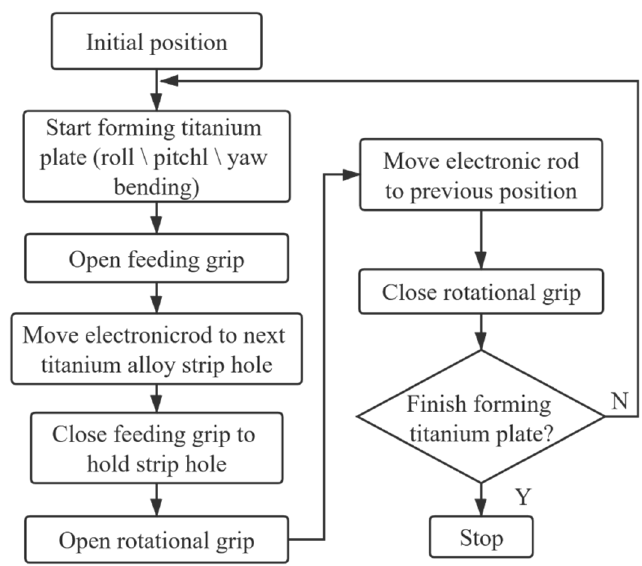
Figure 6. ( a ) Overall experimental device of the forming robot. ( b ) Zooming in on the top of the forming robot.